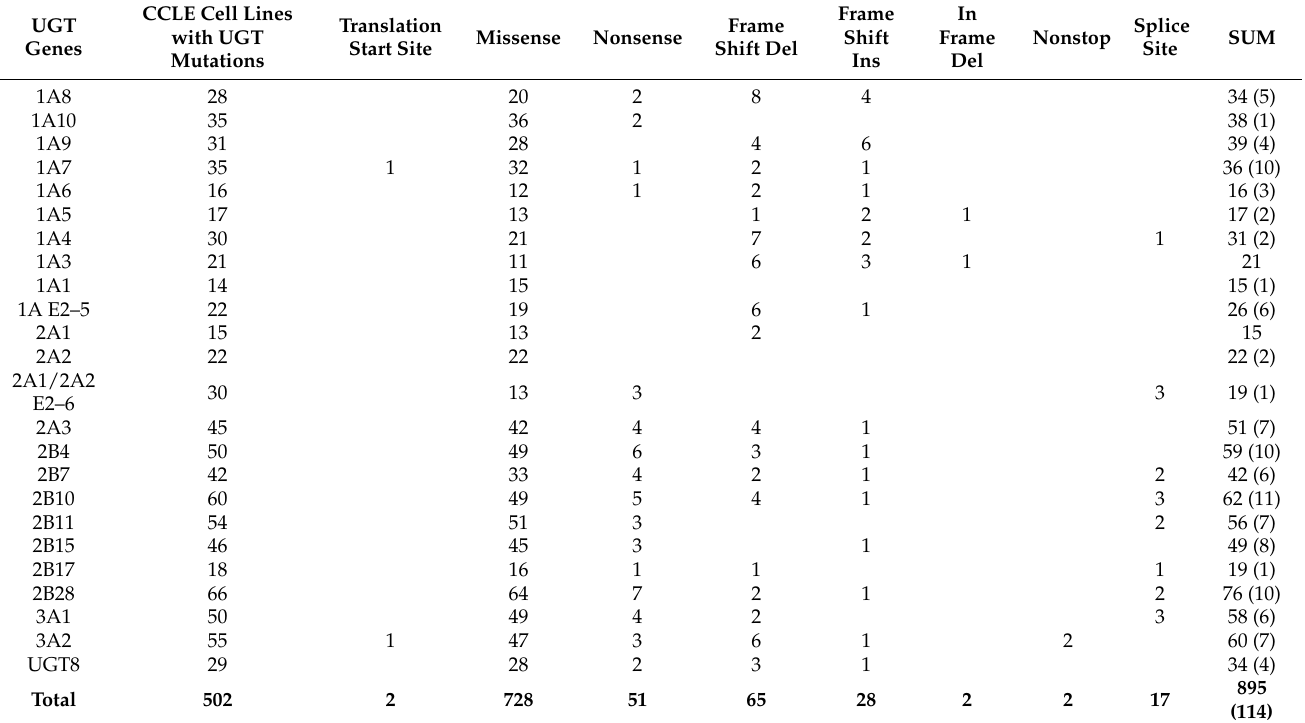
Table 3. Mutations in UGT genes in 1568 CCLE (Cancer Cell Line Encyclopedia, Broad 2019) cell lines. CCLE Cell Lines UGT with Genes